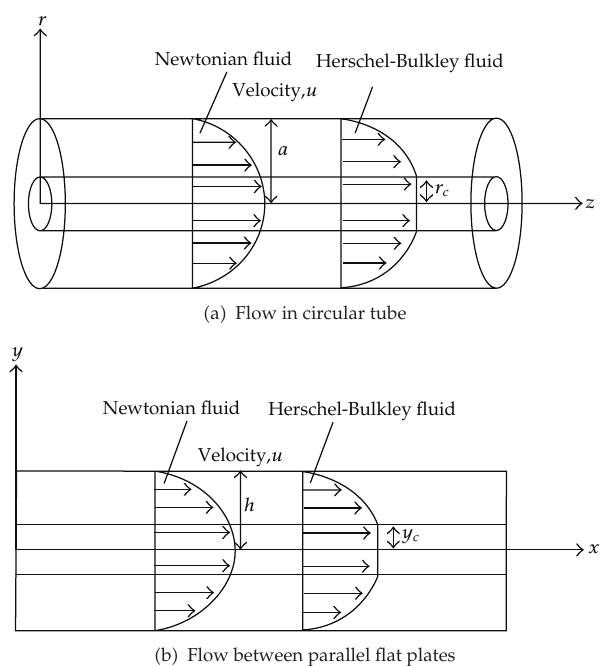
Figure 1: The geometry of the fluid